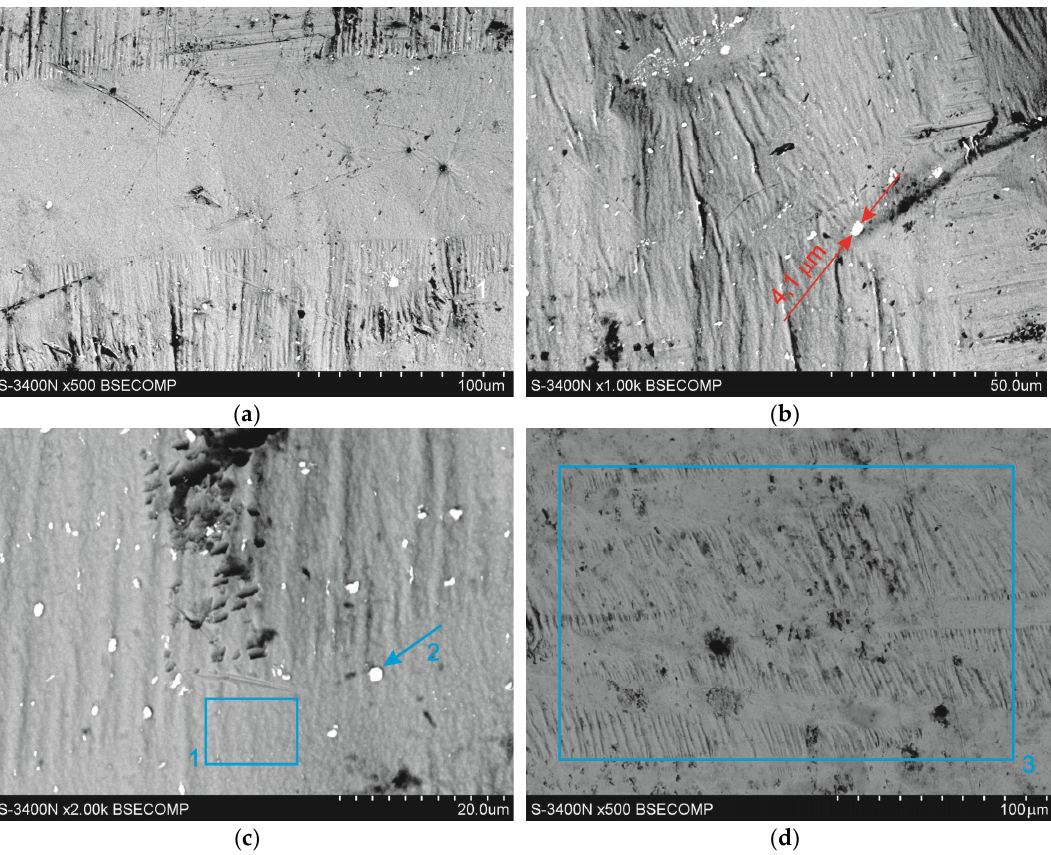
Figure 4. Microstructure (SEM) of the Zn-AlNiBi coating surface: ( a ) sight of the coating surface, ( b , c ) bismuth precipitation on the top surface, and the microstructure (SEM) of the “pure” zinc coating surface ( d ).